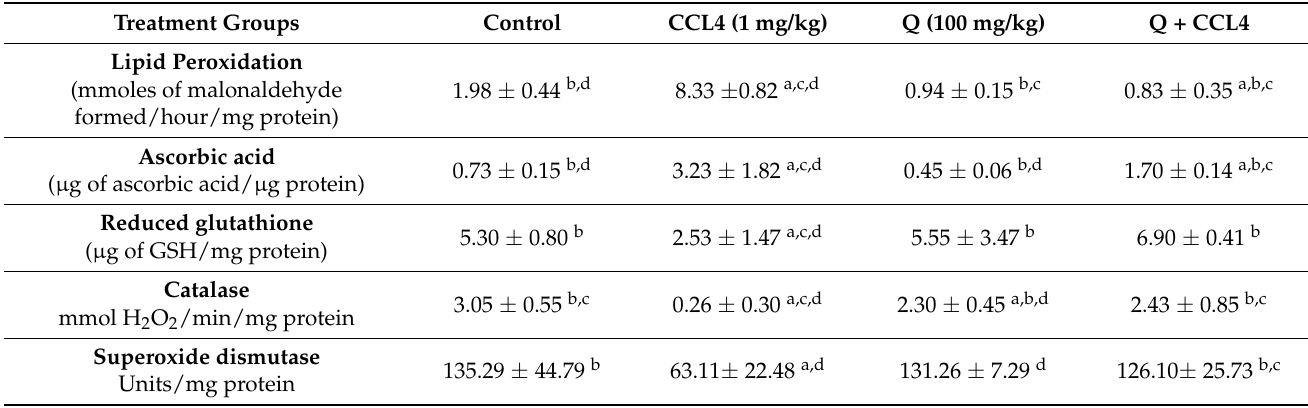
Table 1. Effect of quercetin on CCL4 induced oxidative stress in the brains of control and experimental rats. Treatment Groups